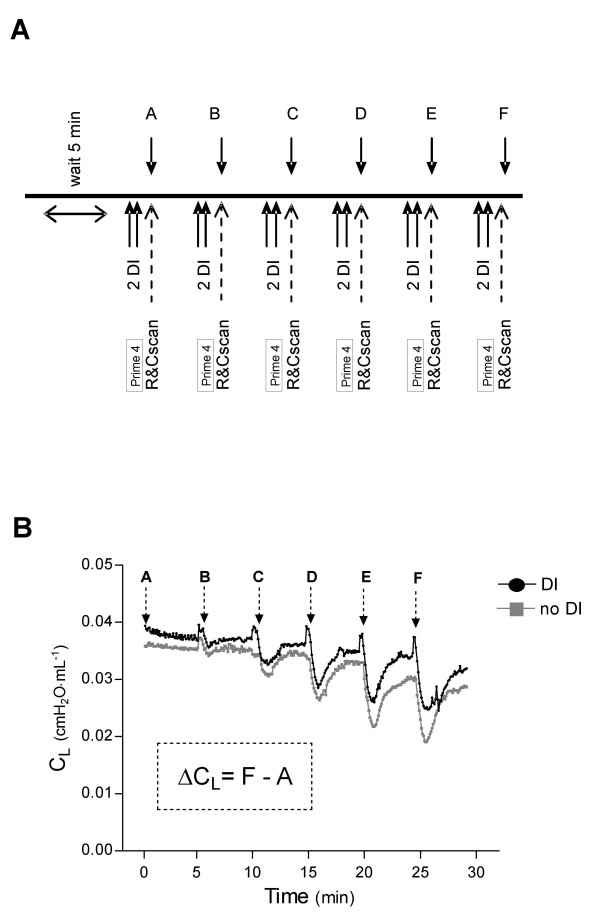
Schematic presentation of study design and graph describing tracings and measurements of lung compliance. (A) Experimental protocol. R&Cscan is a program for measuring lung resistance and compliance with the single compartment model. A perturbation of forced oscillation was performed for 4 s (Prime 4, Zrs measurements) and was used in the acute 17-day (OVA'17 and PBS'17 animals) and chronic 98-day protocol (OVA'98 and PBS'98 animals). During A → F, methacholine (MCh) or phosphate buffered saline (PBS) was administrated or nothing was given. MCh or PBS was administrated 20 s after last DI. (B) Tracings of lung compliance (CL) obtained by R&Cscan indicating measurement points for CL (A → F) and ΔCL with and without deep inspirations (DI).